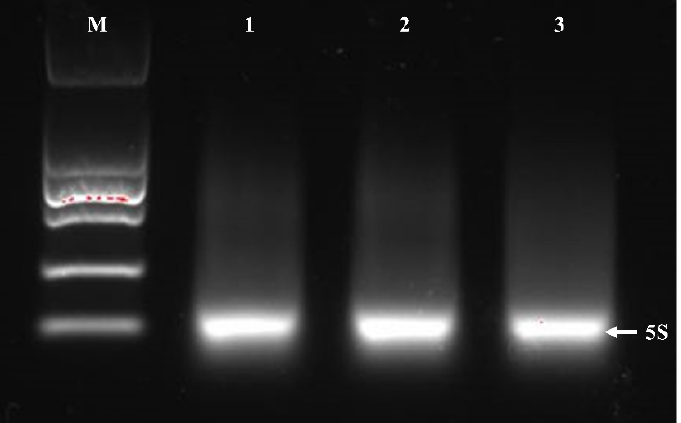
Figure 4. Agarose gel-electrophoresis of RNA from three Bacillus strains by improved RNAiso Plus method. From left to right, electrophoresis Lane M was DL15000 DNA marker, electrophoresis Lanes 1–3 were Bacillus sample-1 RNA, Bacillus sample-2 RNA and Bacillus sample-3 RNA. The white arrow indicates the position of the 5S electrophoresis band.